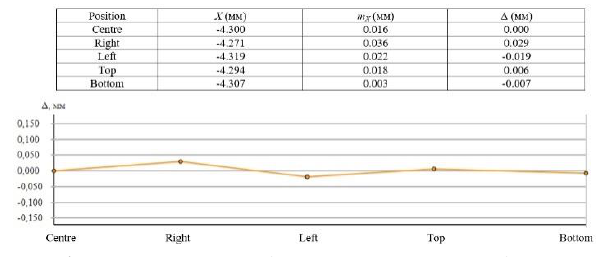
Figure 9. The results of processing photos taken from a distance of 0.3 m and f = 18 mm after the distortion is corrected. As can be seen in Fig. 9 after the distortion is corrected, the residual limit distortion of 17.8 pixels leads to a maximum spread of X values equal to 0.048 mm. The average value of X counts is -4.298 mm, and the RMS deviation is 0.016 mm.